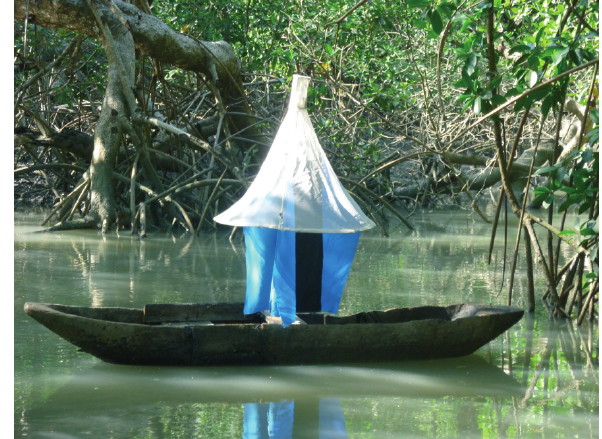
Fig. 2. – Floating biconical trap on the Comoe river, Burkina